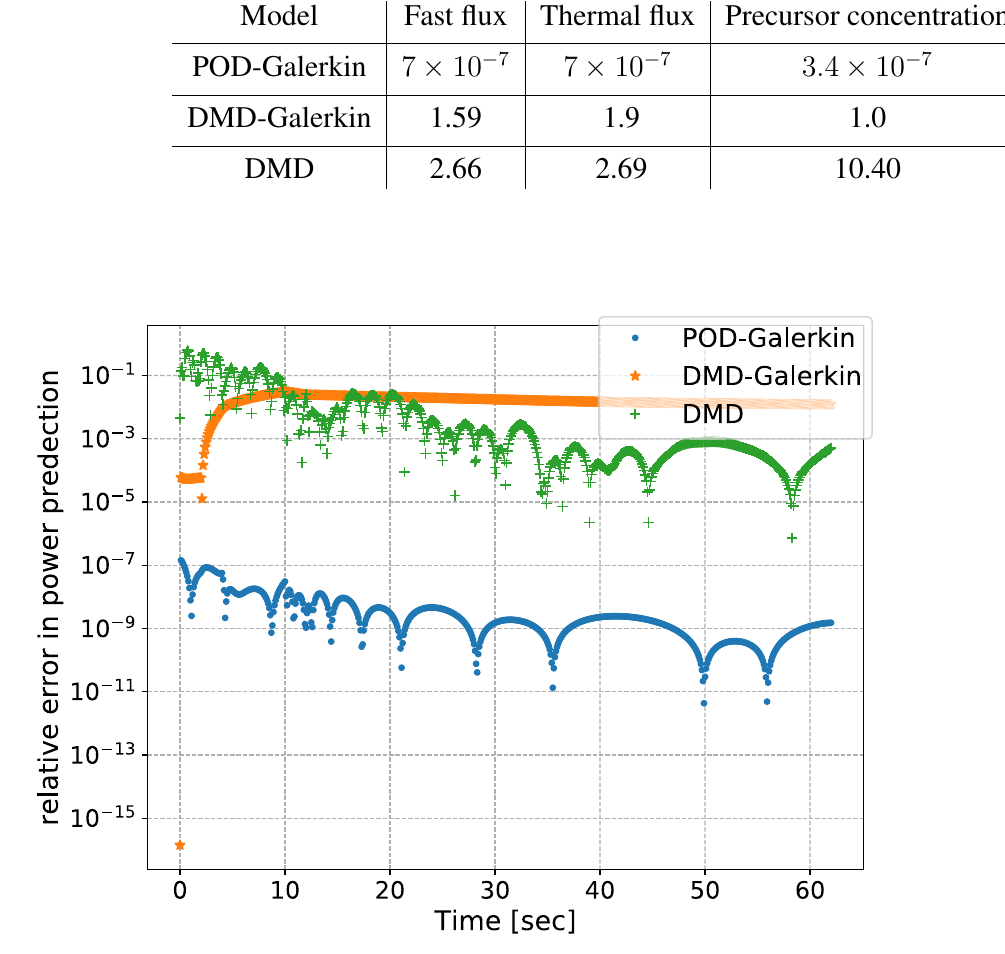
Figure 2: Relative errors in power predictions by the